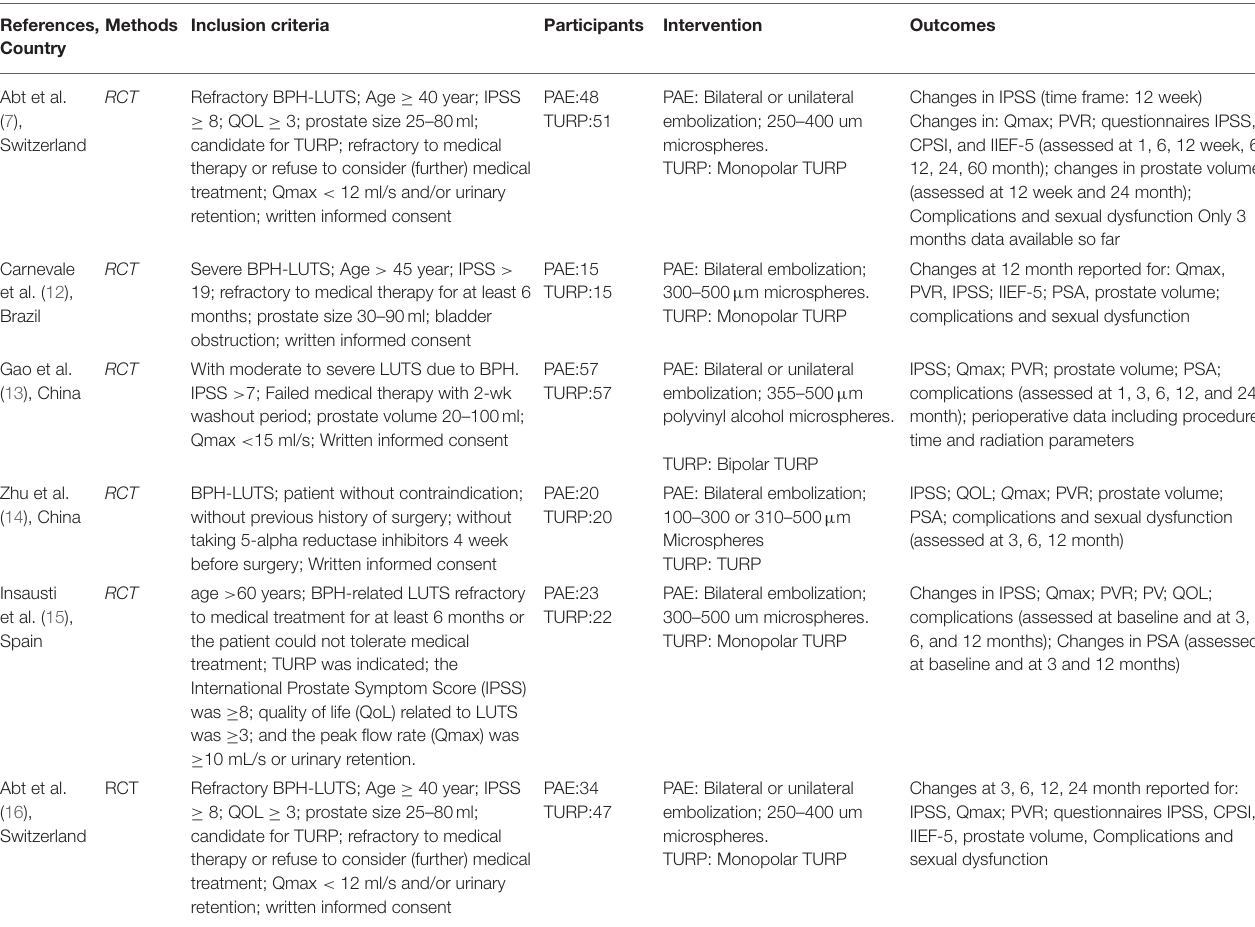
TABLE 1 | General characteristics of the studies included.